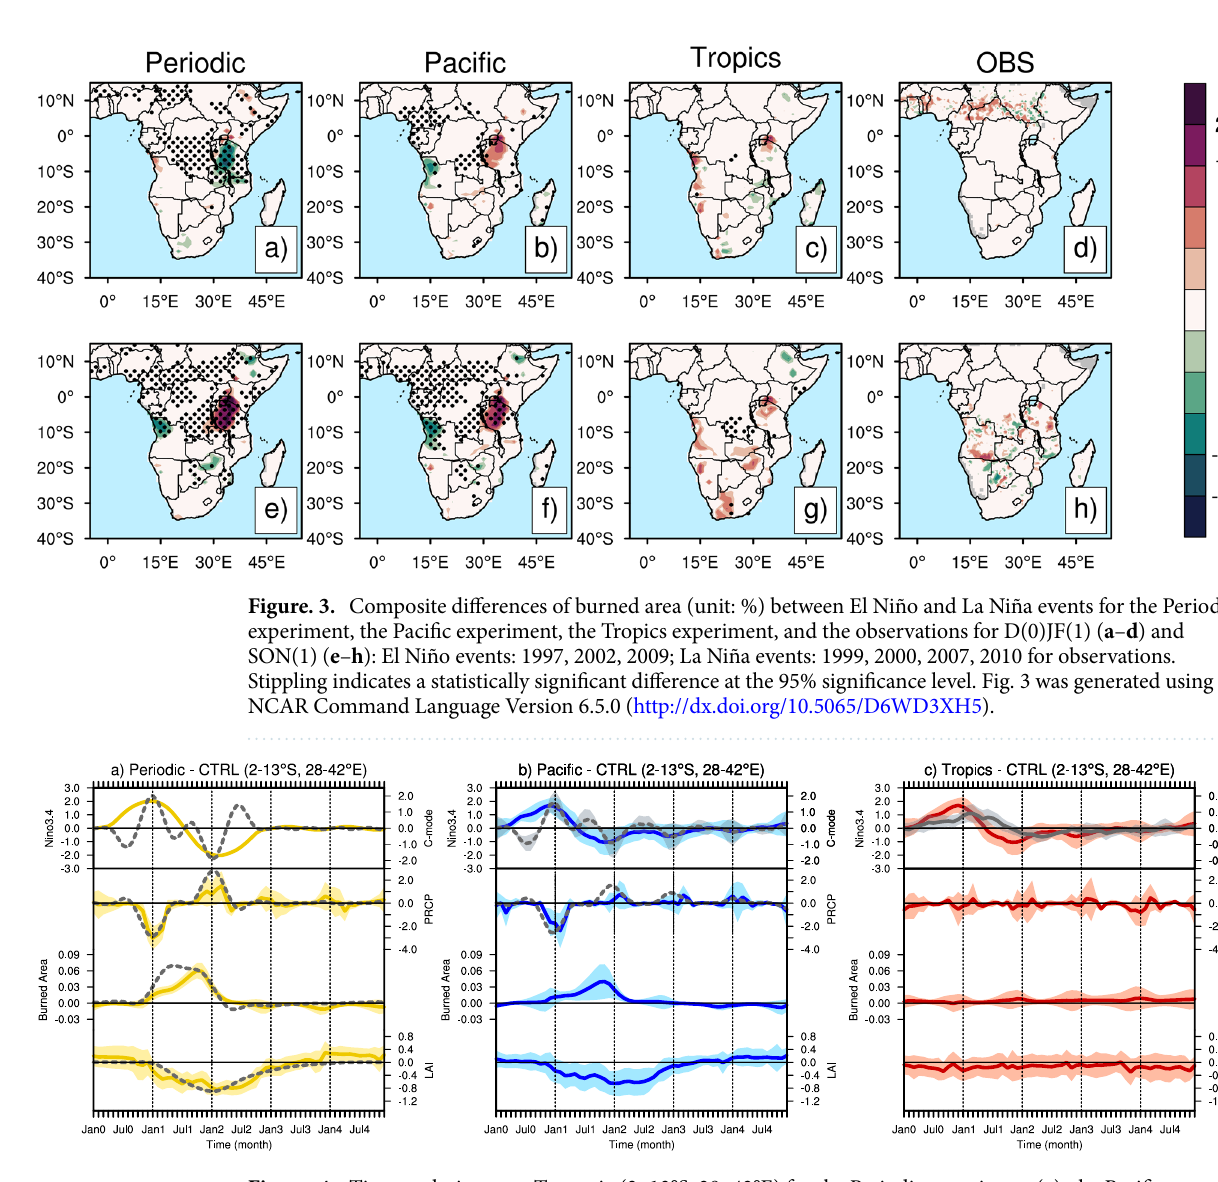
Figure. 4. Time evolution over Tanzania (2–13°S, 28–42°E) for the Periodic experiment ( a ), the Pacific experiment ( b ) and the Tropics experiment ( c ): Niño3.4 index (solid yellow/blue/red line; unit: K), C-mode index (dashed gray line; unit: K), Tropical Indian Ocean (TIO) SST anomalies (solid gray line; unit: K), precipitation anomalies (solid yellow/blue/red line; unit: mm/day), reconstructed precipitation anomalies (dashed gray line), burned area (solid yellow/blue/red line; unit: fraction), reconstructed burned area anomalies (dashed gray line), LAI anomalies (solid yellow/blue/red line; unit: m 2 /m 2 ), and reconstructed LAI anomalies (dashed gray line). Transparent shading indicates ± 1 standard deviation. Fig. 4 was generated using NCAR Command Language Version 6.5.0 (http:// dx. doi. org/ 10. 5065/ D6WD3